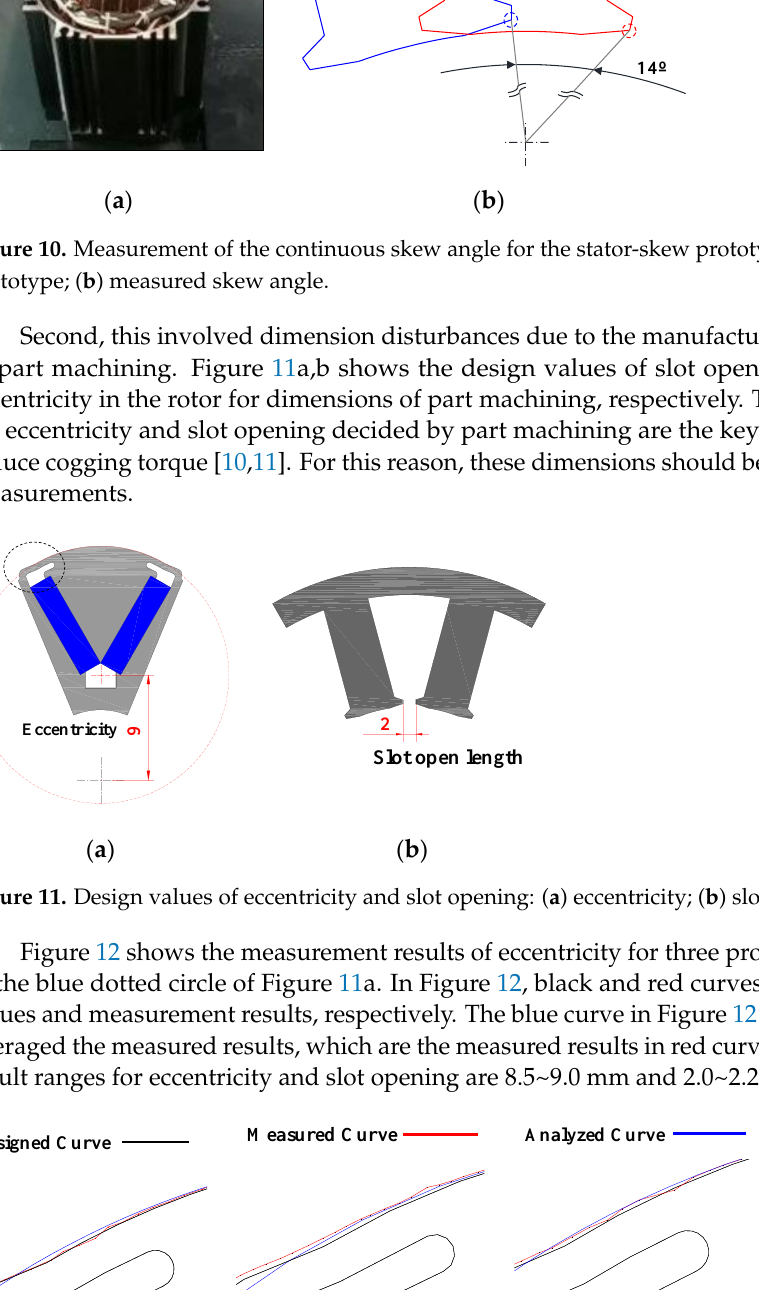
Figure 10. Measurement of the continuous skew angle for the stator-skew prototype: ( a ) stator-skew prototype; ( b ) measured skew angle.